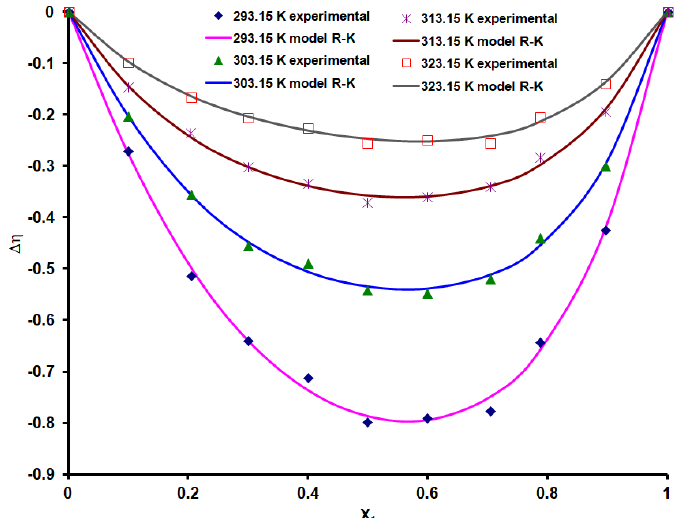
Figure 2. Variation of viscosity deviation ( Δη ) with mole fractions at different temperatures.